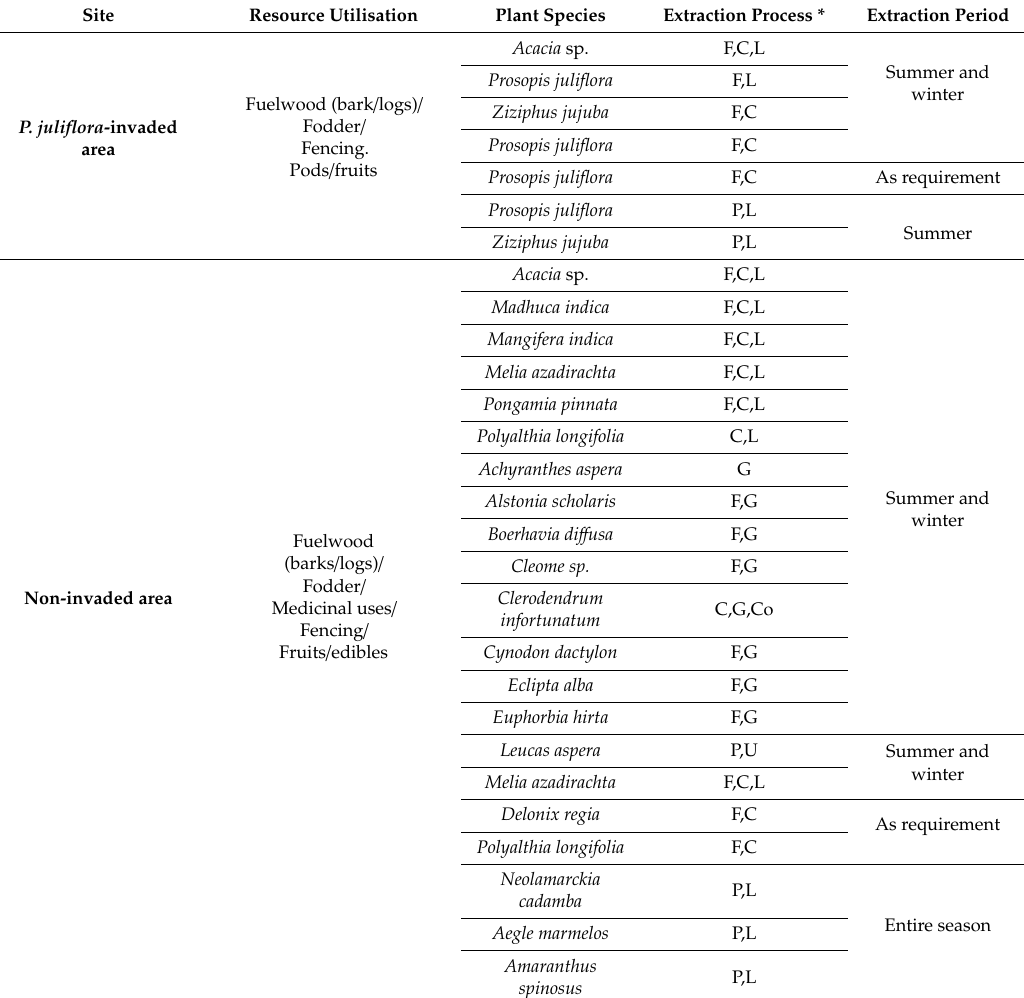
Table4. Resourceextractionandutilisationpatternbytheresidentsinthestudyareas( P.juliflora -invaded area and non-invaded area in same